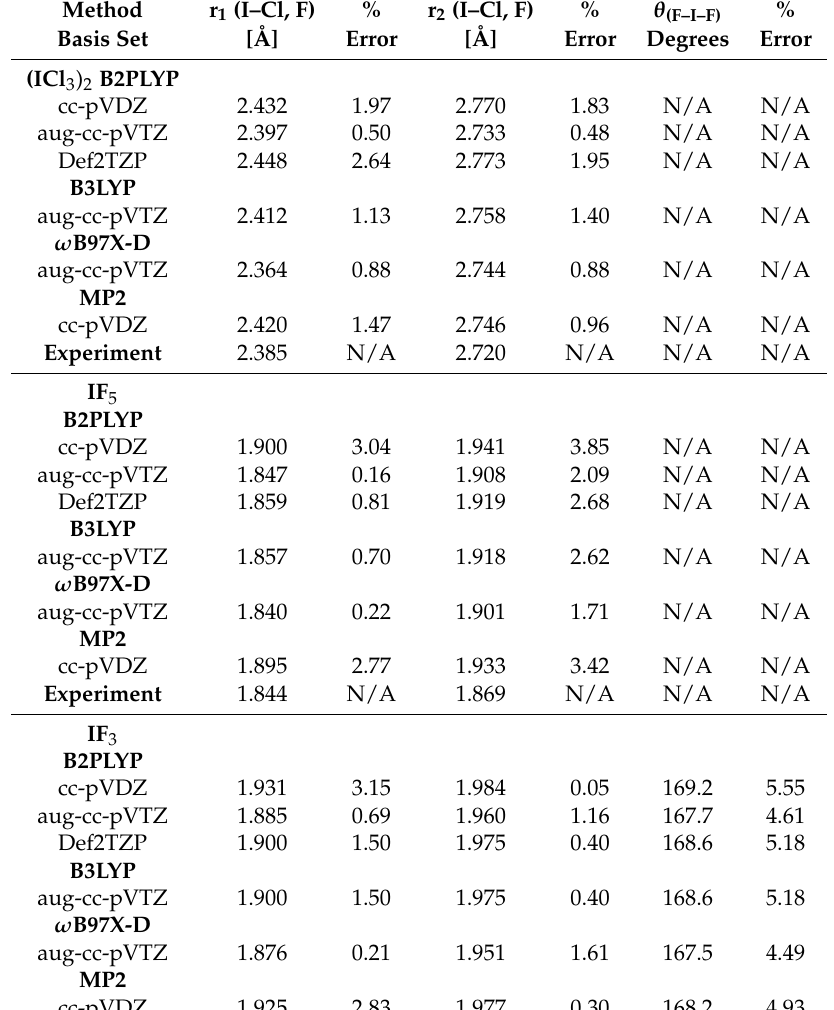
Table A1. Calculated and experimental bond lengths and bond angles for the (ICl 3 ) 2 dimer, IF 5 , and IF 3 , showing B2PLYP and ω B97X-D/aug-cc-pVTZ levels of theory giving closest agreement with the experiment